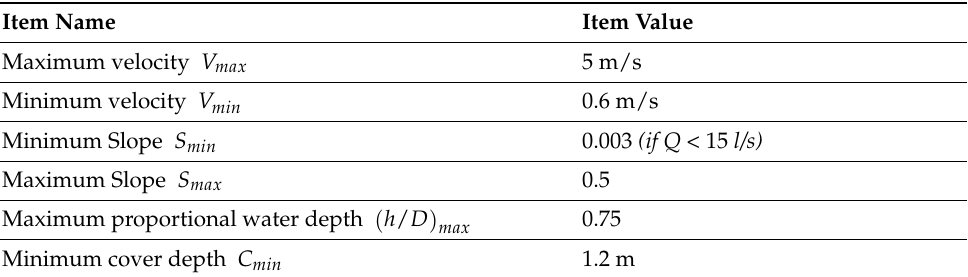
Table 1. Design constraints for the case study.